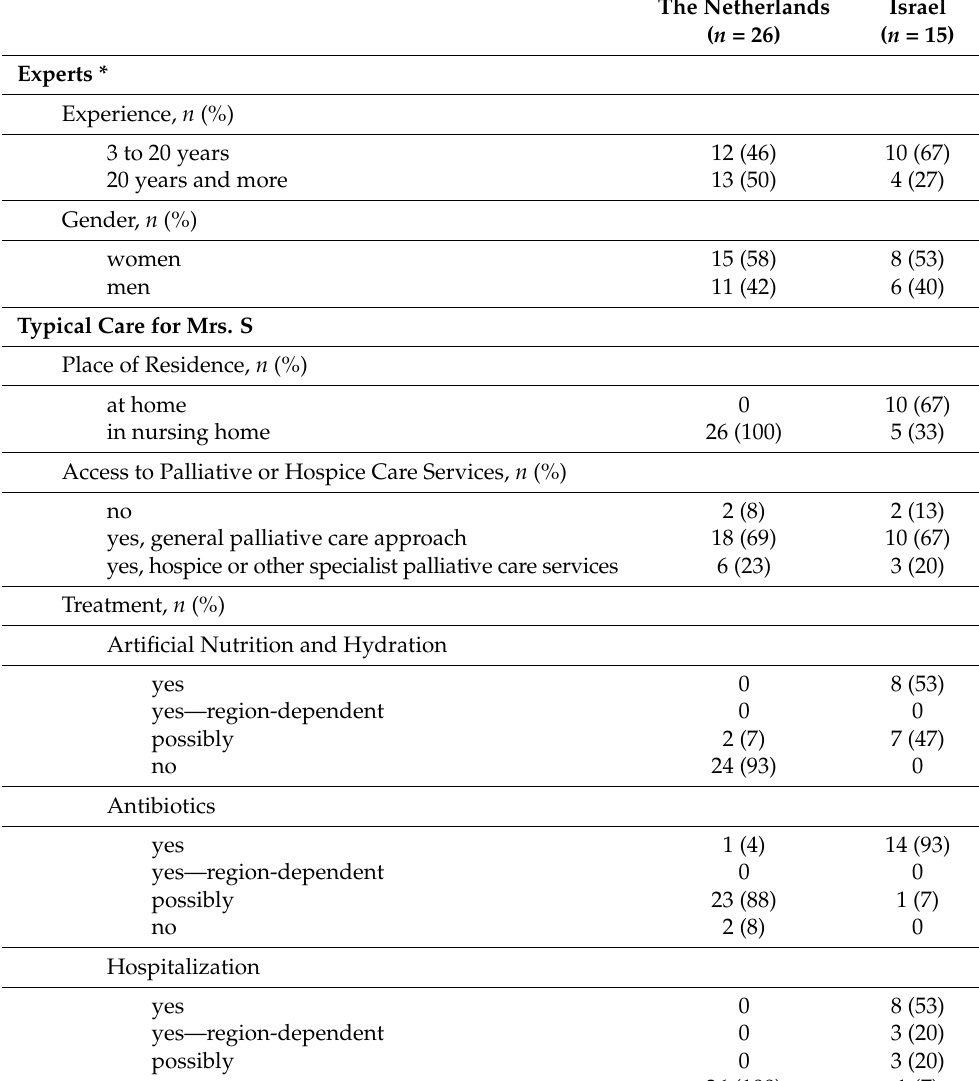
Table 2. National expert physicians’ evaluations of what kind of care Mrs. S would receive in The Netherlands and in Israel.